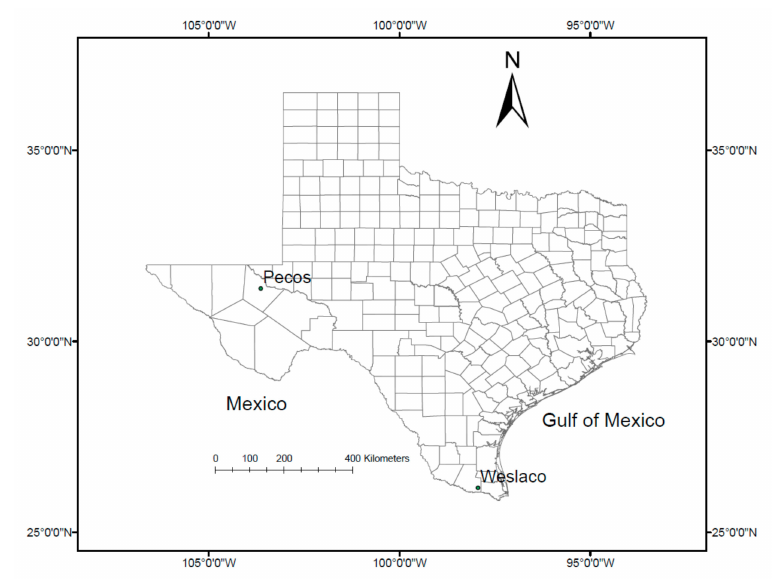
Figure 1. Map of the locations where energy sorghum responses were evaluated. Table 1. Initial soil conditions of the fields where experiments took place. Weslaco, Hidalgo silt